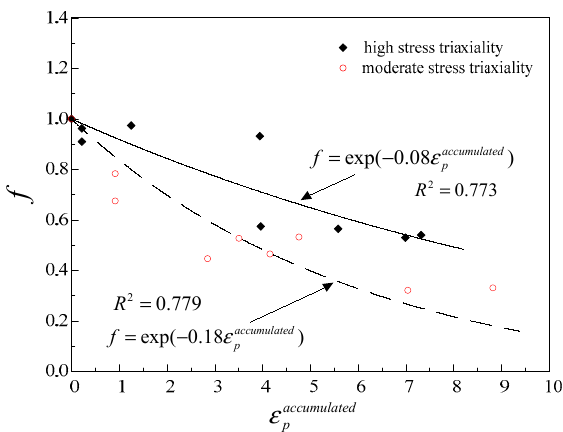
Figure 10. Calibration of damage degradation parameter at high and moderate stress triaxiality.